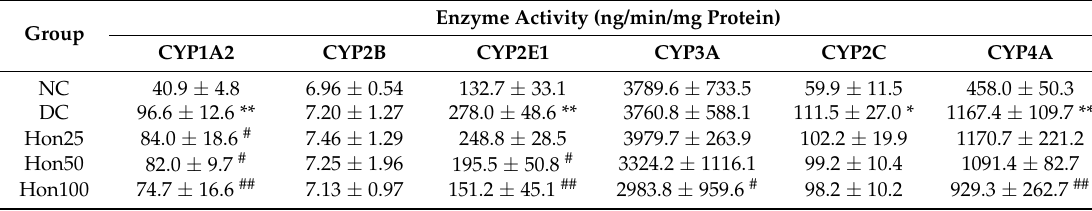
Table 1. Effects of Hon on activity of CYP450 of diabetic rats ( n = 6).